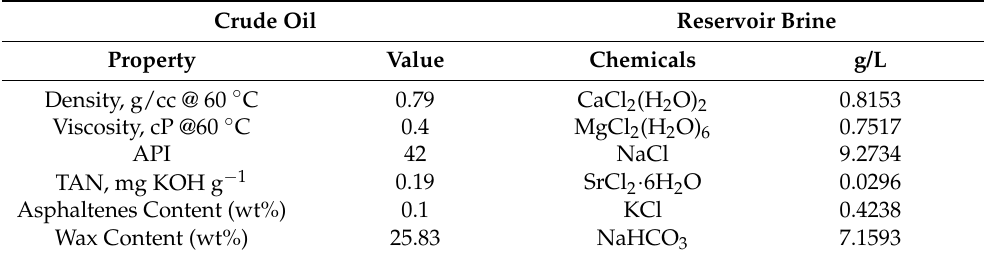
Table 4. Oil and brine composition.